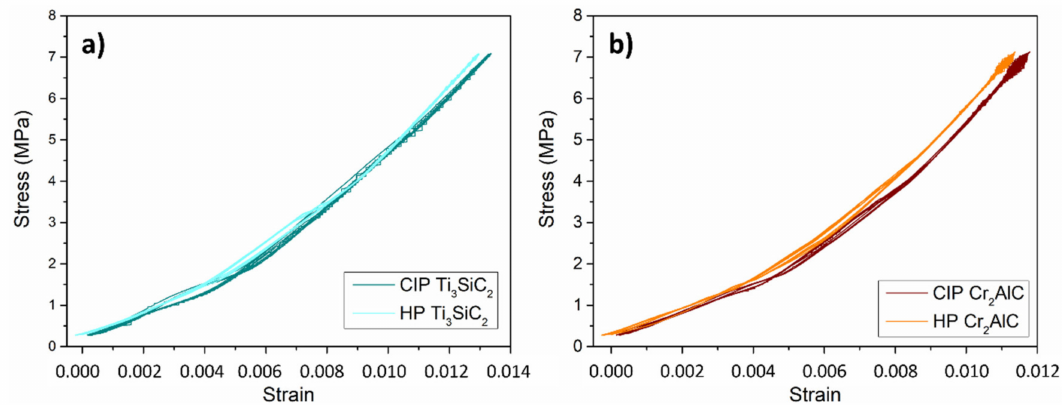
Figure 9. The cyclic micro-compressive stress-strain behavior of CIP and sintered and HP samples of ( a ) Ti 3 SiC 2 and ( b ) Cr 2 AlC at a load of 500 N with a pressure rate of 1